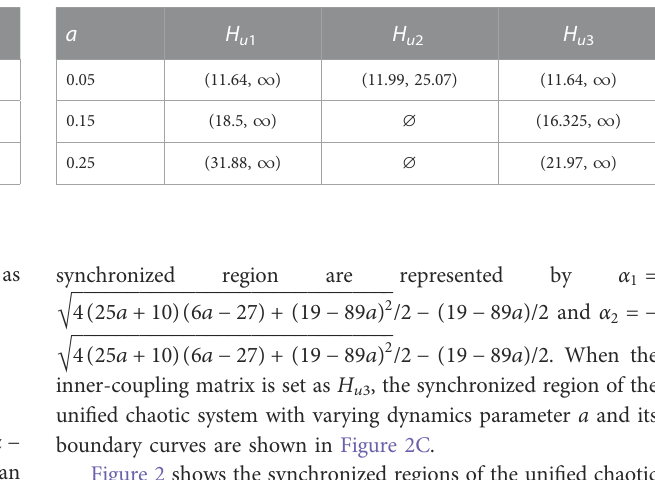
TABLE 1 Synchronized regions of the Lü system under different sign inter- coupling